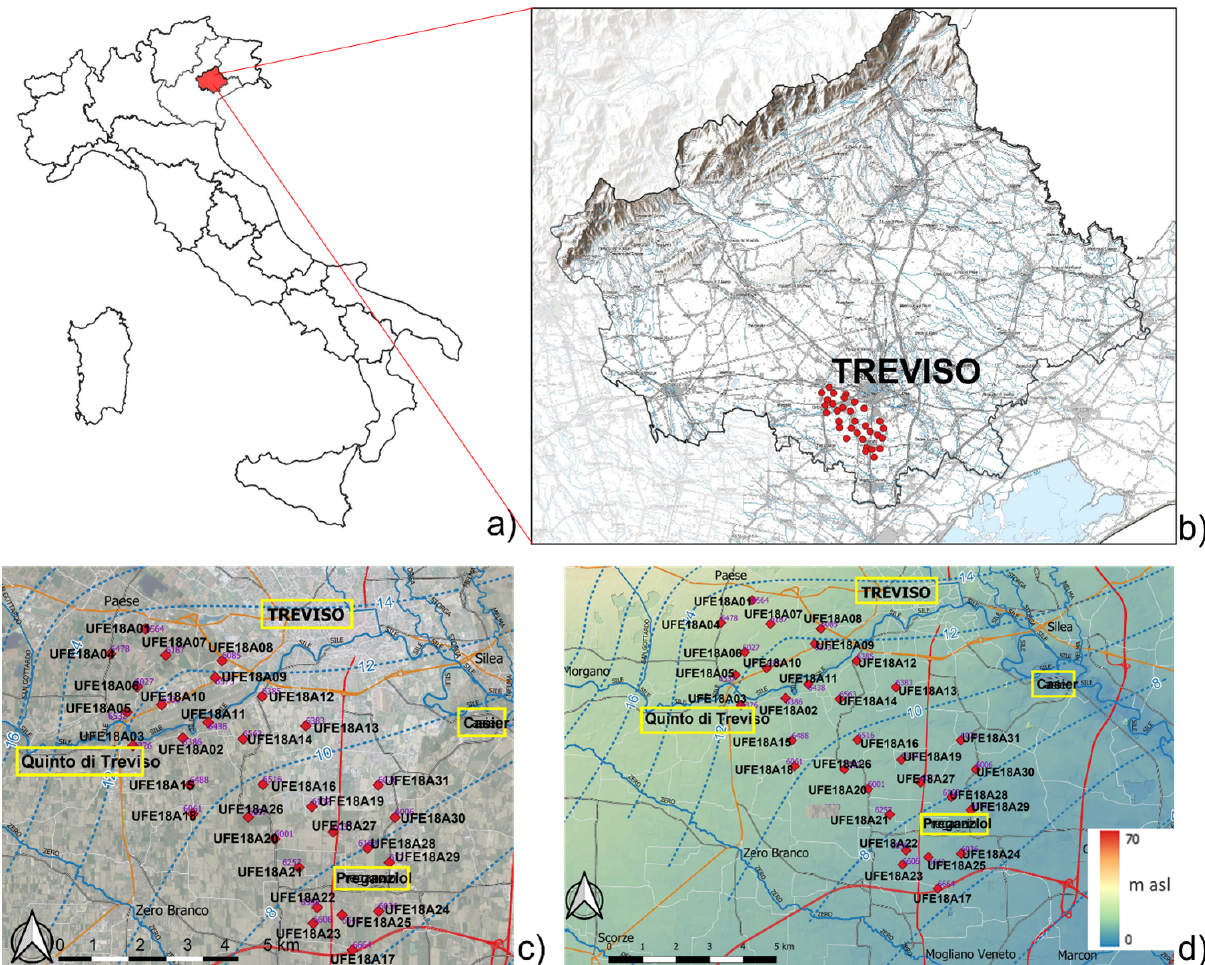
Figure 1. Map of the sampling site: (a) Treviso area in the north of Italy coloured in red; (b) location of the sampling wells in the south part of Treviso area; (c) detailed topography map of the sampling wells; (d) detailed hydrogeological map of the sampling wells. All the maps are created using QGIS 3.16 based on the map explained in Mazzola (2003). The four main withdrawal countries are highlighted in light yellow: Quinto di Treviso, Treviso, Preganziol and Casier.